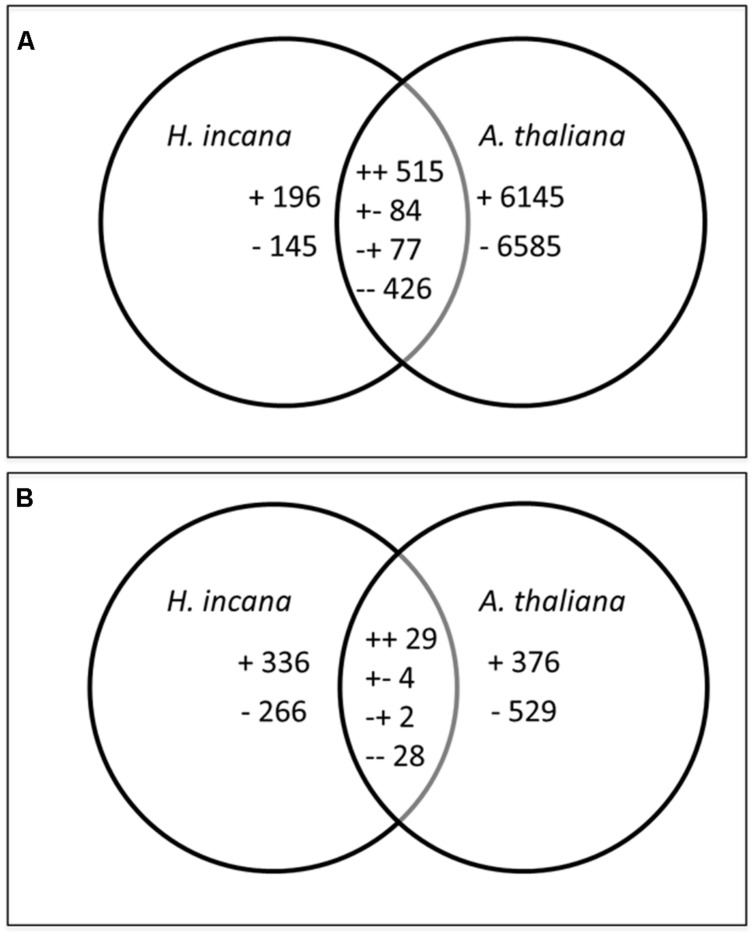
Venn diagrams representing the distribution of regulated genes between H. incana and Arabidopsis thaliana in roots (A) and shoots (B) after Pb exposure. +, up-regulated; -, down-regulated; ++, up-regulated in both species, --, down-regulated in both species, +-, up-regulated in H. incana and down-regulated in A. thaliana and -+, down-regulated in H. incana and up-regulated in A. thaliana.